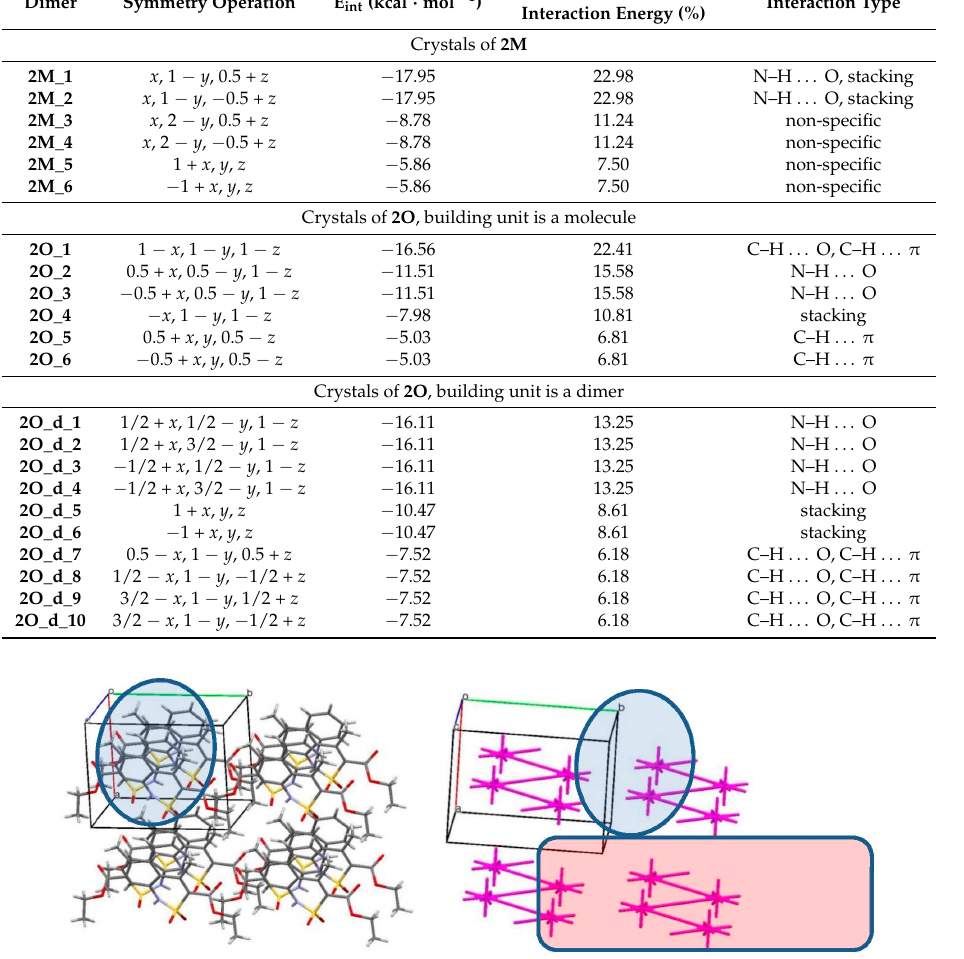
Figure 6. The packing of ester 2 in the monoclinic polymorphic form 2M presented as the packing of molecules ( left ) and packing of energy-vector diagrams ( right ). The primary basic structural motif (chain) is highlighted in blue. The secondary basic structural motif (layer) is highlighted in pink.